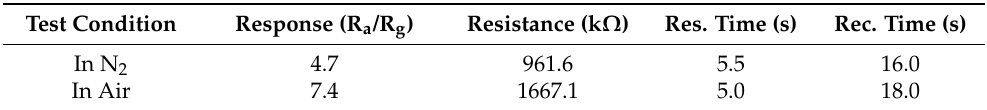
Figure 5. The gas-sensing mechanism of the SnO 2 nanoflowers sensor. The left side is the schematic diagram, and the right indicates the energy band diagram. Table 2. The sensing performance of the nanoflowers sensor to 60 ppm HCHO in N 2 and Air,